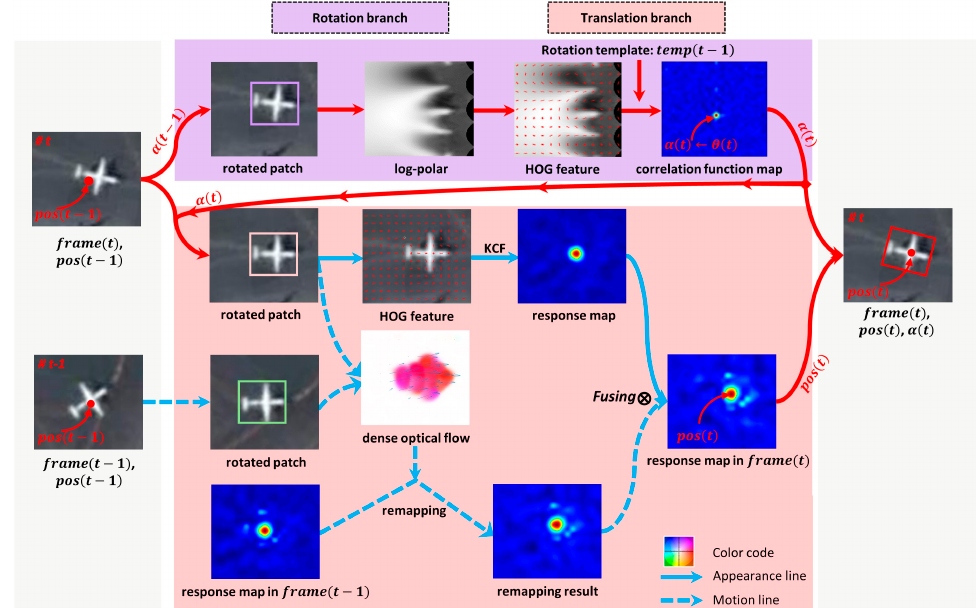
Figure 3. Overall framework of the proposed RAMC algorithm. pos ( t − 1 ) and α ( t − 1 ) denote the position and angle of the object at frame t − 1, respectively. The color code is shown for visualizing the optical flow, in which the color denotes the displacement direction, and the saturation represents the displacement magnitude. The appearance and motion lines represent the positioning process of appearance and motion information, respectively. Two frames separated by T are selected as adjacent frames to show the overall tracking framework. It yields more intuitive rotation and translation of the object for visualization.